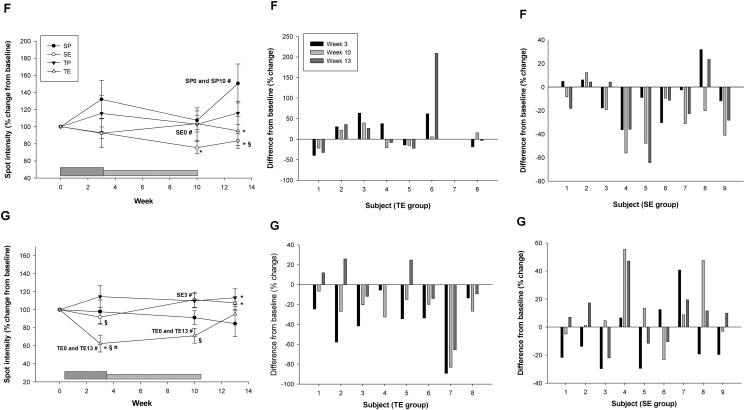
Spots with an overall Darbepoietin-α effect.For the spots G and F that exhibited a significant Darbepoietin-α effect are shown average change in spot intensity. SP (sedentary-placebo), SE (sedentary-ESA), TP (training-placebo), and TE (training-ESA). The dark grey box at the bottom indicates the boosting period (first 3 weeks) and the light grey box the maintenance period (weeks 4–10), subjects were not treated during weeks 11–13 (wash-out phase). Individual changes (%) from baseline in all subjects in the TE and SE group are also shown. Data are expressed as mean ± SE, level of significance are p<0.05. * significant from SP within same time-point, # significant from different time-point within group (time point are given), § significant from TP within same time-point, ¤ significant from SE within same time-point.